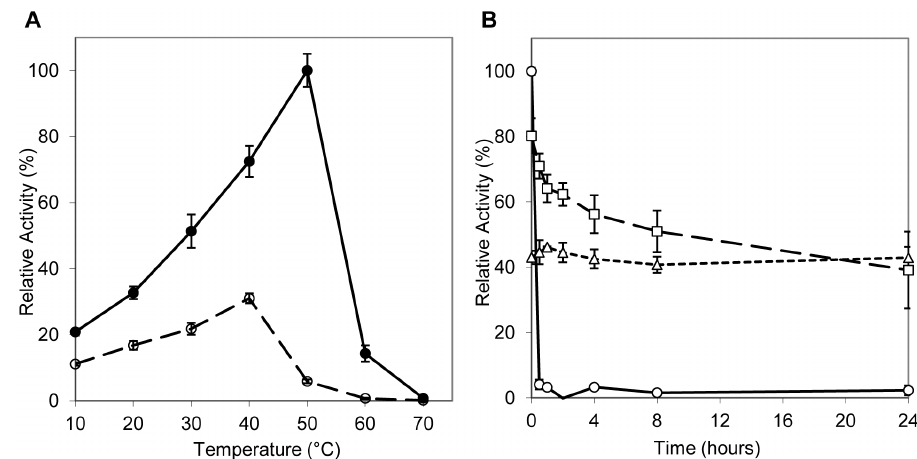
Figure 3. Effect of temperature on alginate lyase activity and stability of activity. (A) Effect of temperature on activity with (filled circles) and without NaCl (open circles). Activity was determined, after 10 minutes at the target temperature, by the increase in absorbance at 235 nm over the absorbance of the control reaction without enzyme. (B) Thermostability of alginate lyase activity. AlgMsp was incubated at 50 u C (circles), 37 u C (squares), and 25 u C (triangles) for 24 hours in 20 mM Tris, 200 mM NaCl, pH 8. Samples were tested at 0, 0.5, 1, 2, 4, 8, and 24 hours for residual activity as above. Activity was normalized to 100% for the most active sample.